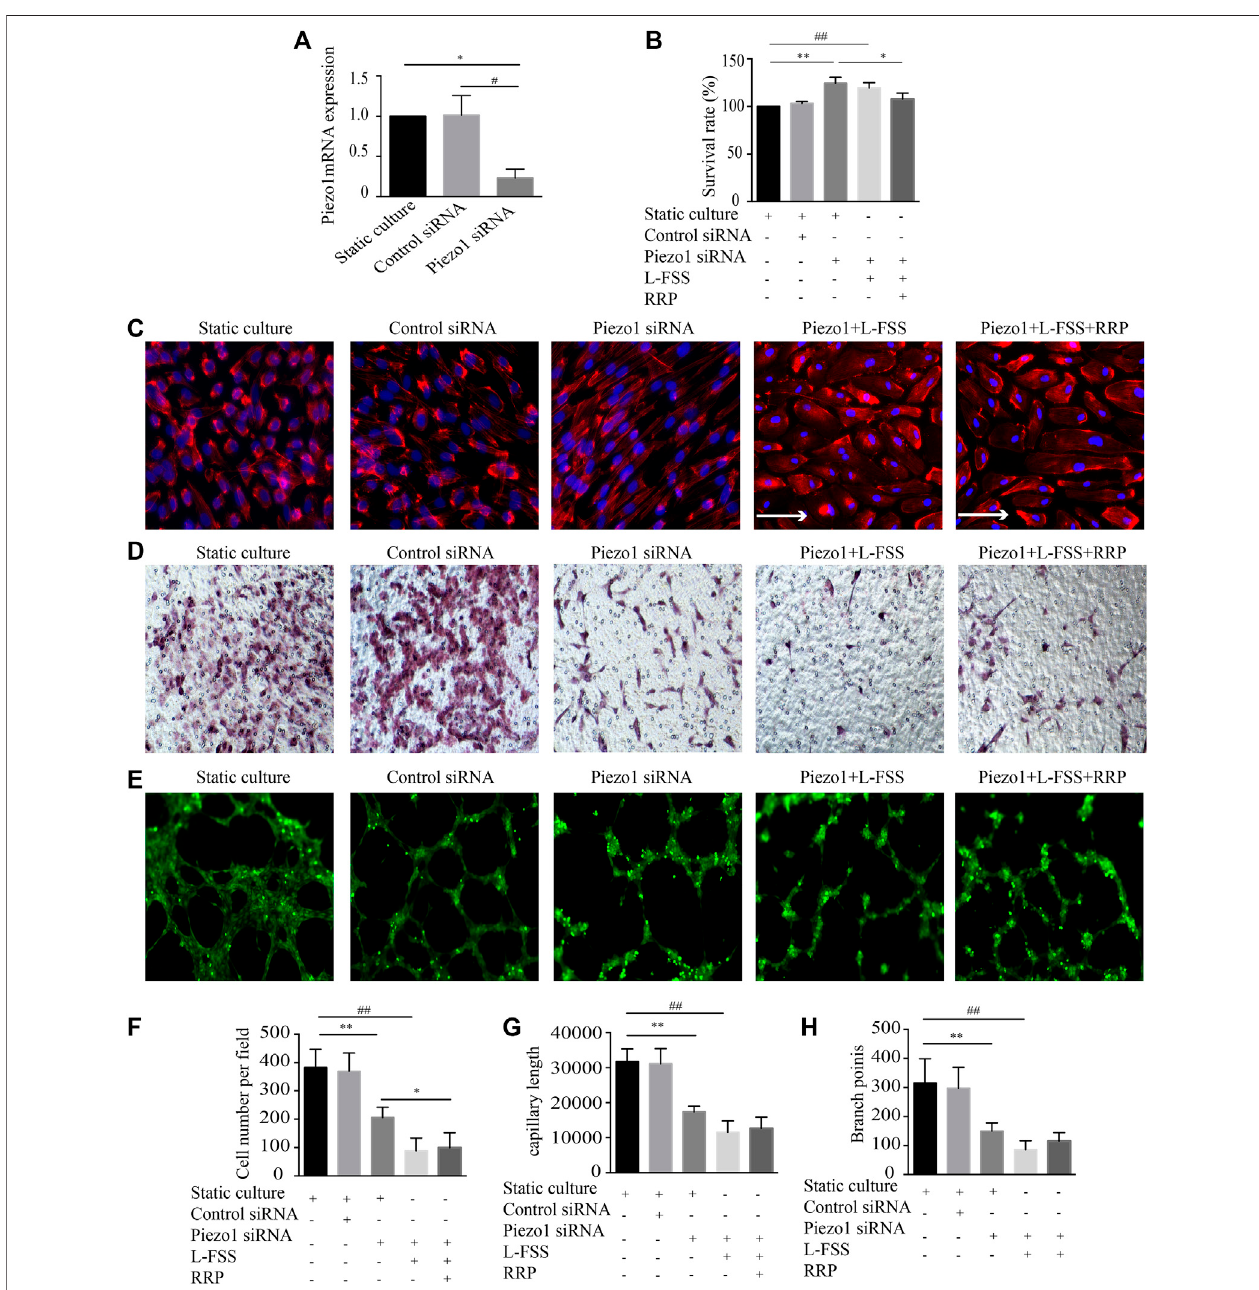
FIGURE5| InhibitionofPiezo1usingsiRNAabrogatestheprotectiveeffectsofRRPonHUVECinjury. (A) ThemRNAexpressionofPiezo1detectedbyqRT-PCRin indicated groups. (B) Proliferation activity of HUVECs, * p < 0.05 vs. Piezo1 siRNA group. (C) Cellular alignment was analyzed by staining cells with phalloidin (red) and DAPI (blue), scale bars (cid:2) 50 μ m, arrows indicate the fl uid direction. (D,F) Representative images of the migration of HUVECs and the calculated cell migration number, scale bars (cid:2) 50 μ m, * p < 0.05, ** p < 0.001 vs. Piezo1 siRNA group, ## p < 0.001 vs. Piezo1 siRNA + L-FSS group. (E) Representative images of the formation of capillary-like tubules in HUVECs, scale bars (cid:2) 200 μ m. (G,H) Capillary morphogenesis was quanti fi ed by calculating the branch points (G) and capillary length (H) , ** p < 0.001 vs. Piezo1 siRNA group, # p < 0.05, ## p < 0.001 vs. Piezo1 siRNA + L-FSS